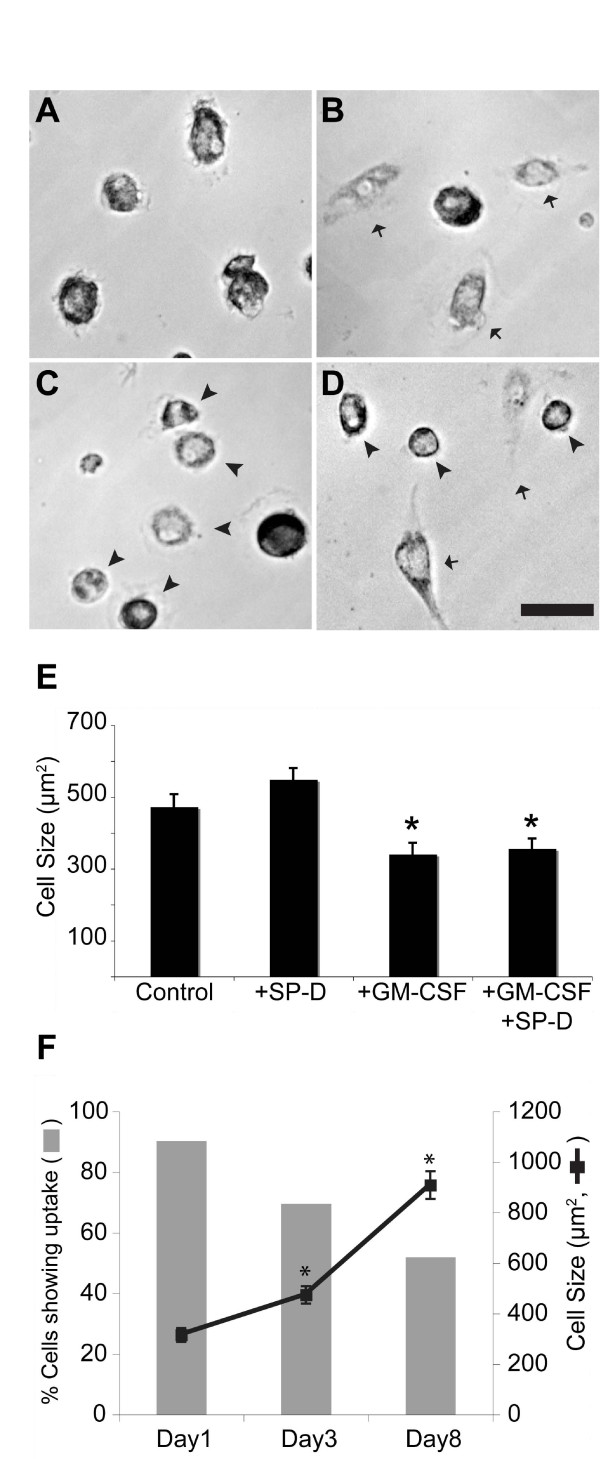
SP-D and GM-CSF affect the shape and size of the cells. (A-D) Adherent viable cells were grown in the absence or presence of SP-D (1 μg/ml) and/or GM-CSF (10 ng/ml) for 24 h. (A) Cells without any added proteins have relatively the same size and shape. (B) In the presence of SP-D, more cells became elongated in shape (arrows). (C) In the presence of GM-CSF, more cells became small, round or oval (arrowheads). (D) In the presence of both SP-D and GM-CSF, both populations (arrowheads, oval; arrow, elongated) are present. (E) Average cell size shown in the above conditions. Presence of GM-CSF significantly reduced cell size, reflecting the formation of small and spherical/oval cells. The sizes of at least 50 cells were measured in each category. Data are presented as means ± SEM; n = two independent experiments. The means were compared with respective controls using Dunnett's multiple mean comparison procedure (* p < 0.05). (F) Over one week time, many BAL cells changed into elongated and stopped internalizing foreign materials (labeled BSA). Number of cells that actively internalize the foreign material was quantified from the randomly selected images obtained in uptake assays. The increase in cell size was associated with decrease in % cells that internalize BSA. For percent cells that actively internalize, data are presented as the proportion of cells that were able to take up Alexa fluor 647-conjugated BSA in total number of cells present. The mean values were compared with Day1 value using Dunnett's multiple mean comparison procedure (* p < 0.05).